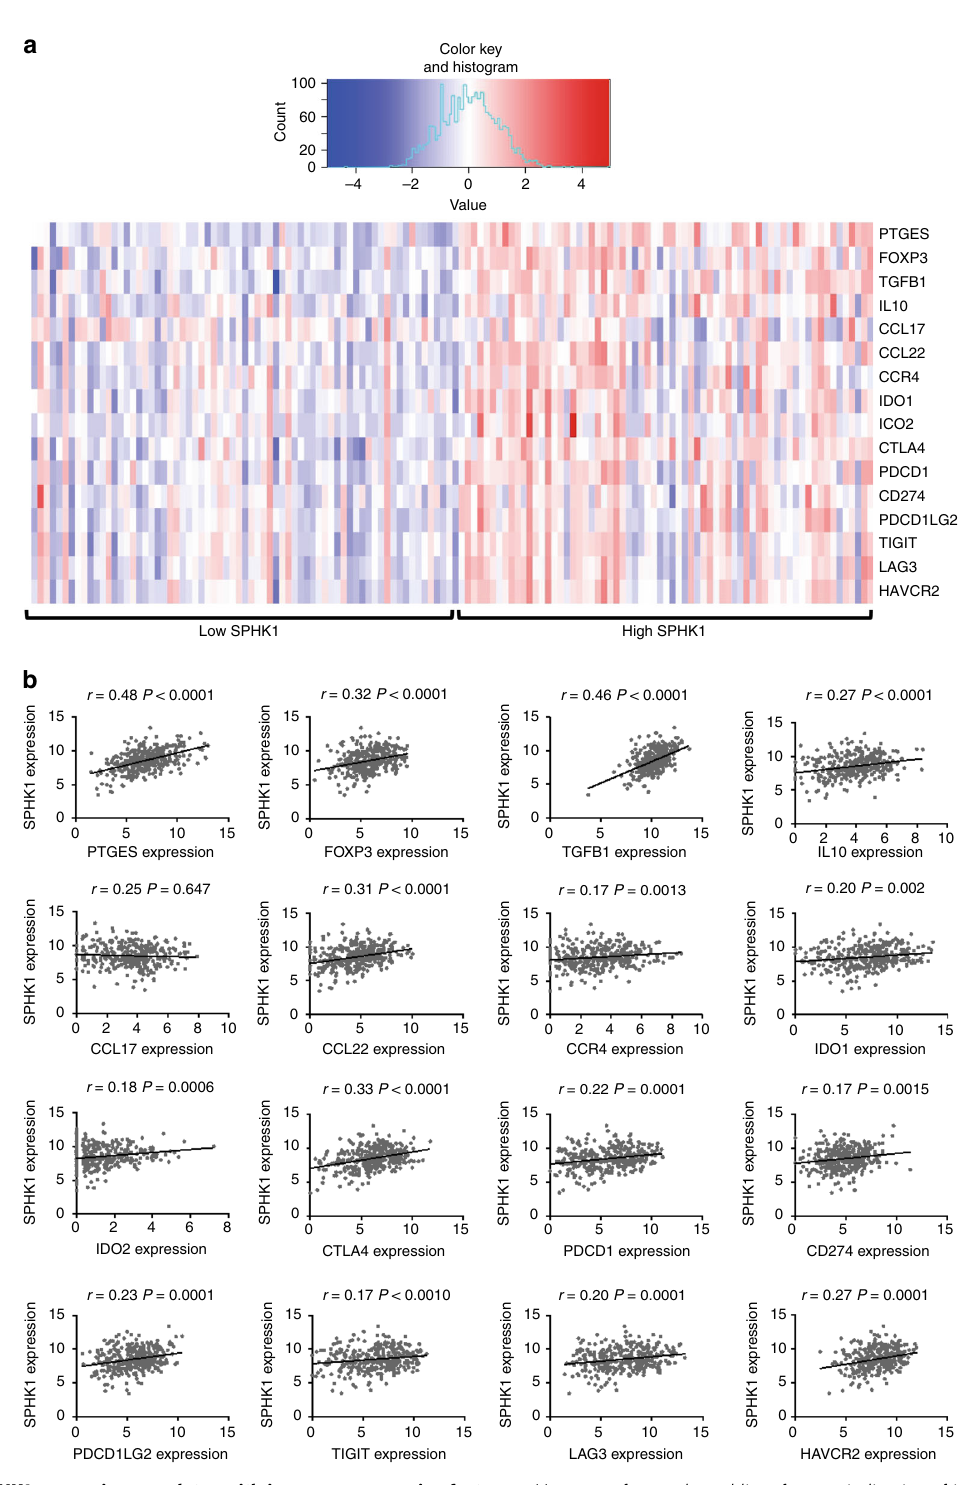
Fig. 7 Human SPHK1 expression correlates with immune suppressive factors. a Heat map for a selected list of genes indicative of immune suppression exhibiting low (20th percentile) and high (80th percentile) SPHK1 expression in melanoma samples using the TCGA cohort. Red indicates high expression and blue indicates low expression relative to the mean expression of the gene across all samples ( n = 136). b Correlations between SPHK1 expression (log2( x + 1) transformed RSEM normalized count) and genes indicative of immune suppression using non-parametric Spearman ’ s test ( n =